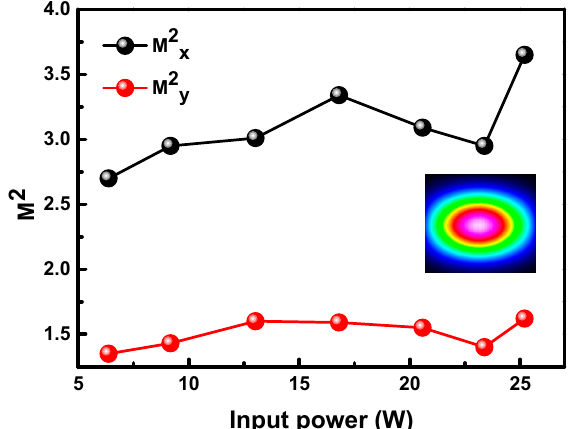
Figure 7. Beam quality M 2 factors of the fundamental laser in x and y directions. The inset is the beam profile at input power of 25 W.